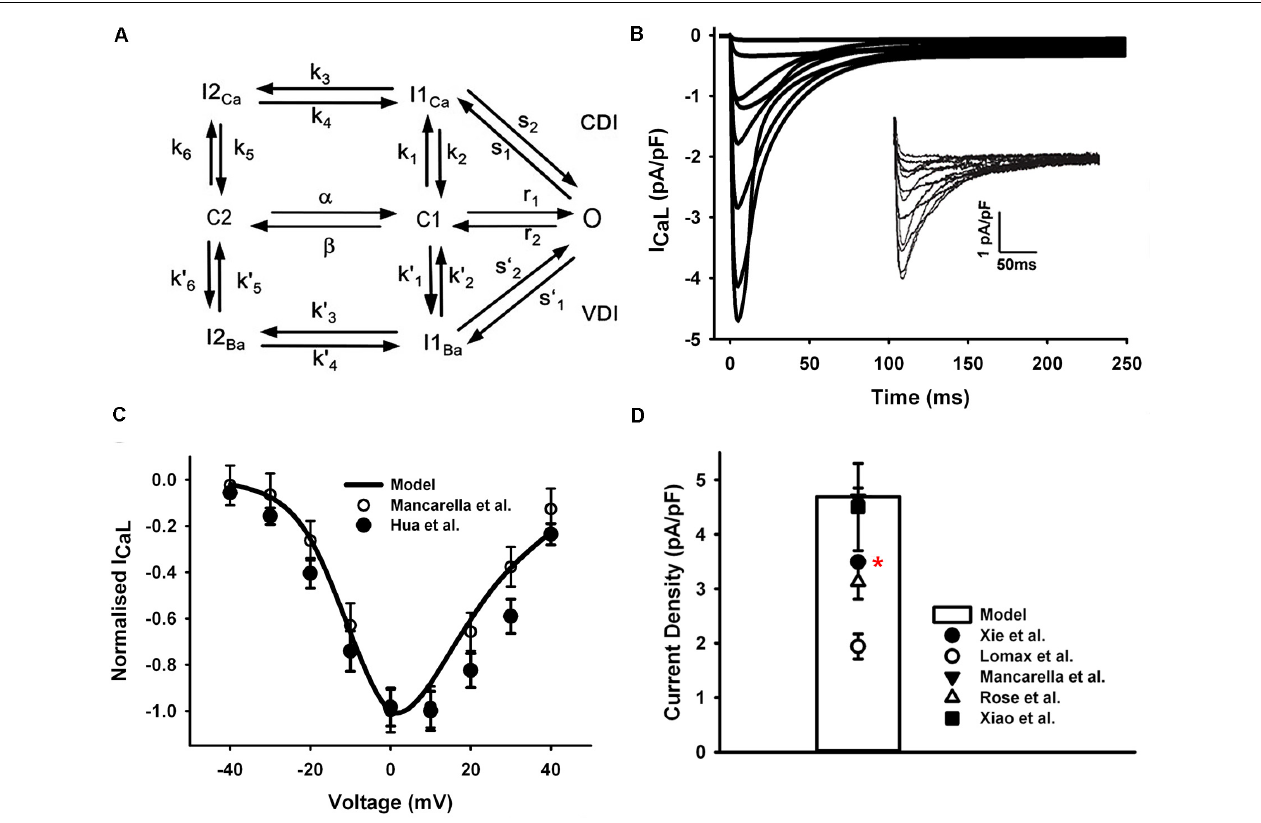
FIGURE 2 | I CaL in the atrial myocyte model and comparison with experimental data. (A) A schematic diagram of the Markov chain model of the L-type Ca 2 + channel (Mahajan et al., 2008). (B) Current traces from simulation and experimental records (inset) from Mancarella et al. (2008). (C) Normalized I–V relationship of I CaL . (D) Peak simulated current density compared with experimental data (Rose et al., 1992; Lomax et al., 2003a; Xiao et al., 2006; Mancarella et al., 2008; Xie et al., 2012). All experiments were conducted at room temperature except the data from Xie et al. at body temperature (marked with a red